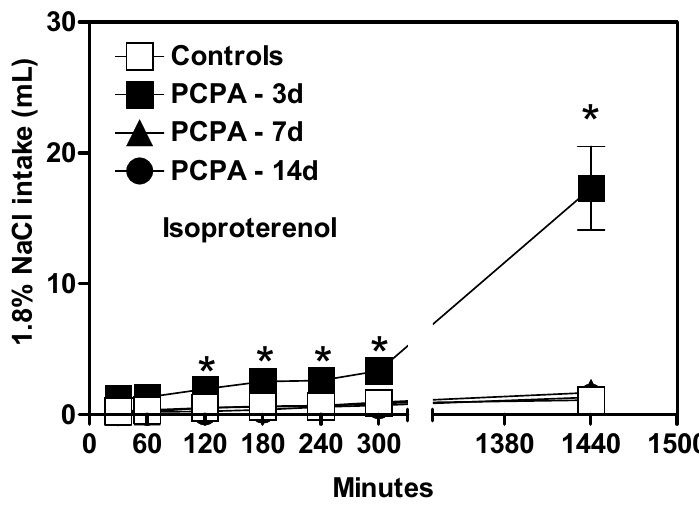
Fig. 4 – Chronic effect of treatment with p-chlorophenylalanine (PCPA, 300 mg/kg, ip , for 2 days), 3, 7 and 14 days after the first injection, on the natriorex- igenic response developed after treatment with isoproterenol (300 µ g/kg, sc ). Mean values represent cumulative 1.8% NaCl intake from 30 min up to 24 h. Data are reported as means ± SE. ∗ P < 0 . 05 compared to